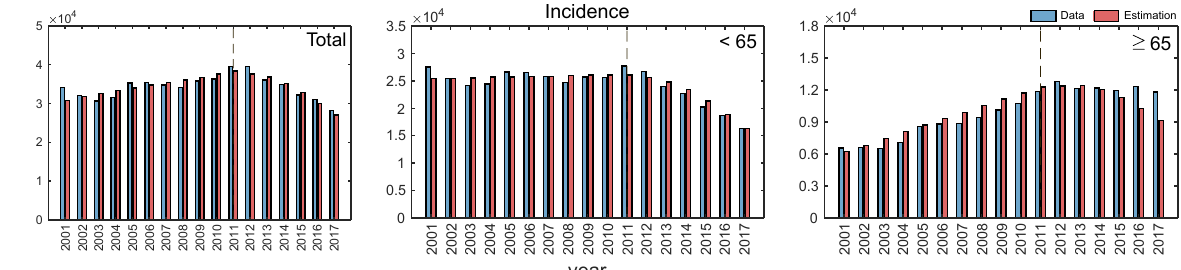
Figure 5. Model parameters were estimated in the 2-time window of 2001 to 2011 and 2012–2018. The leftmost panel showed TB Incidence data (blue bar) and the model output of the one-age group (red bar). Non-elderly TB incidence of the 2-age group is compared in the middle panel (blue for data and red for model output). Elderly TB incidence data (blue bar) and the model output of the 2-age group (red bar) are compared in the rightmost